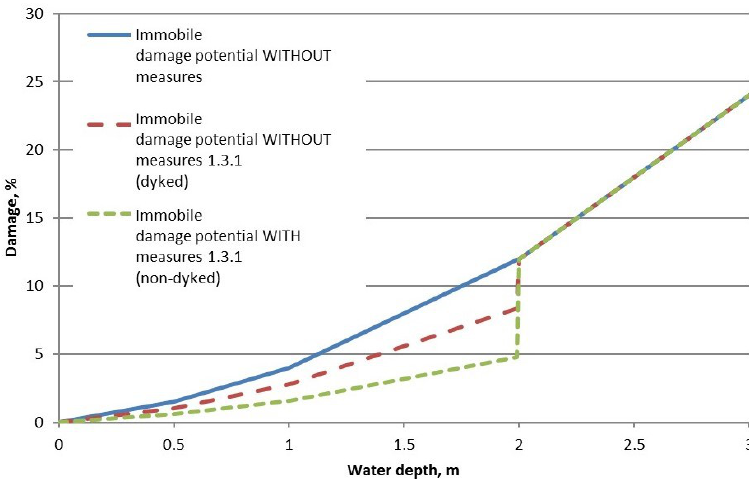
Figure 6. Modification of the damage function for immobile damage (industry) due to the measure “precautionary building” (= measure 1.3.1) for dyked and non-dyked areas [7].